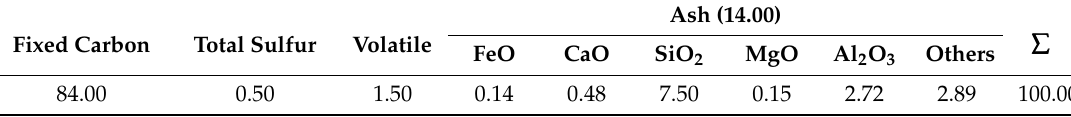
Table 2. Proximate analysis of coke breeze and chemical compositions of the ash (mass fraction, %).